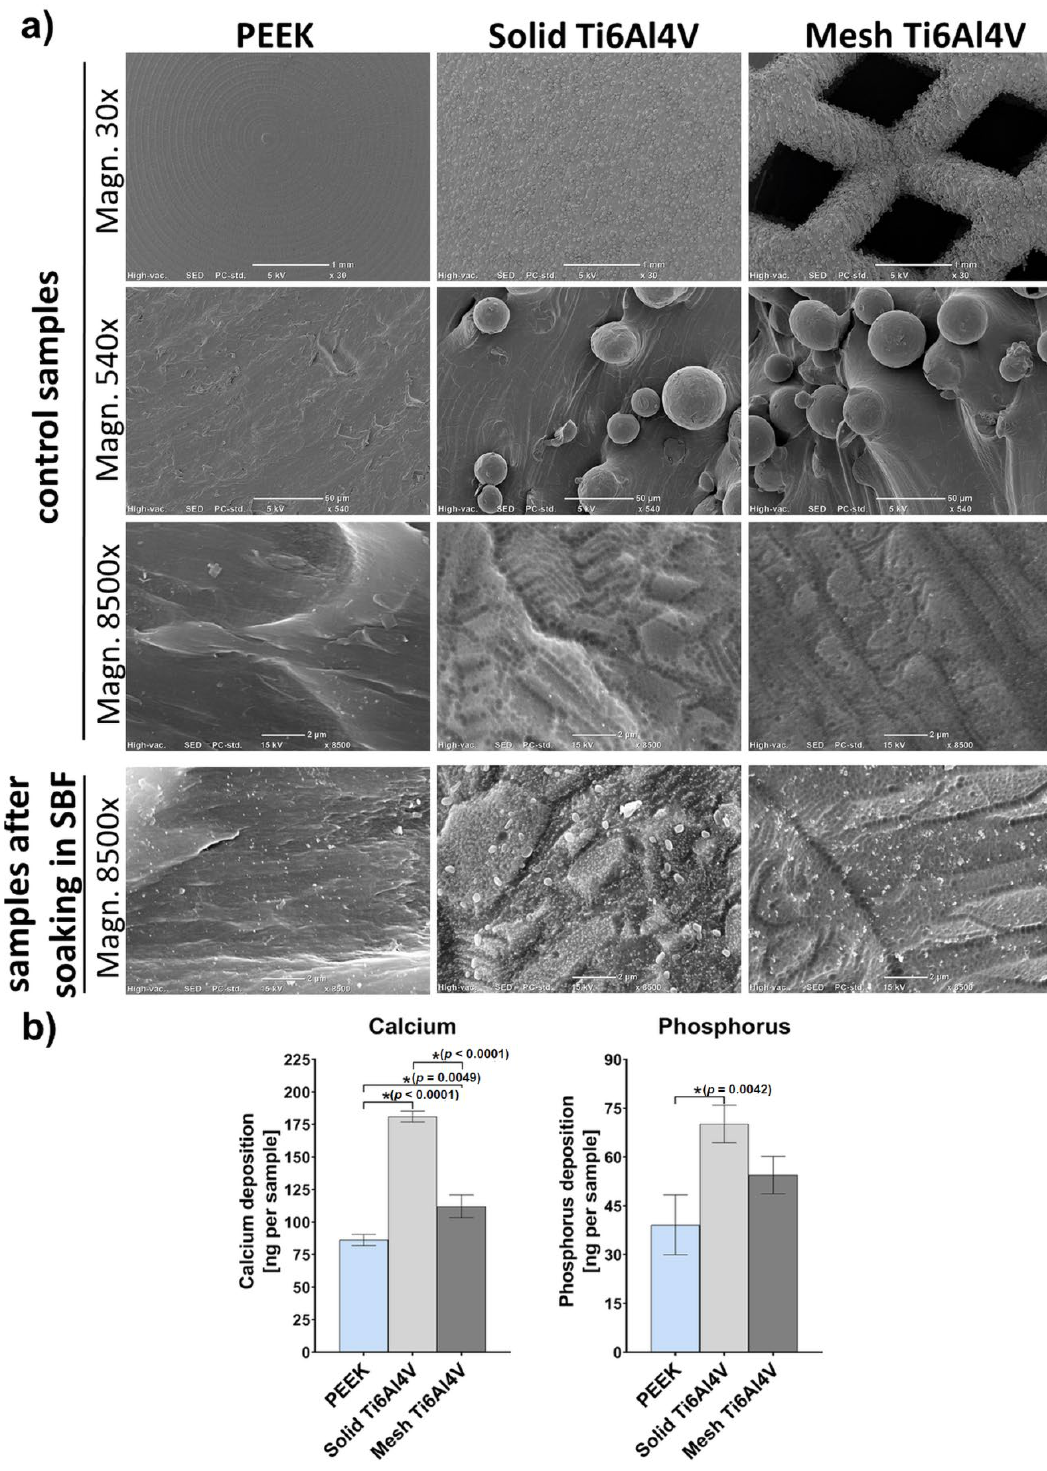
Figure 4. ( a ) Microstructure of samples visualized by SEM before (control samples) and after soaking in SBF for 28 days. ( b ) Quantitative evaluation of the calcium and phosphorus deposition on the surfaces of the samples after soaking in SBF (* indicates statistically significant results according to One-way ANOVA followed by Tukey’s multiple comparison test).